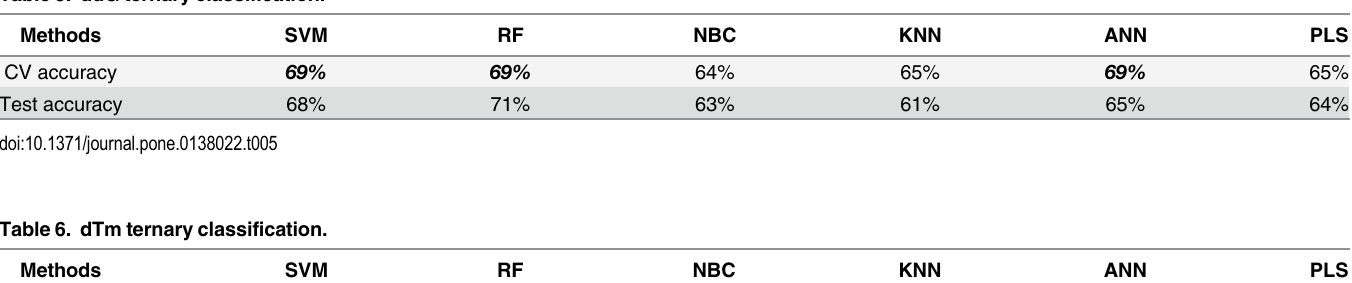
Table 5. ddG ternary classification.